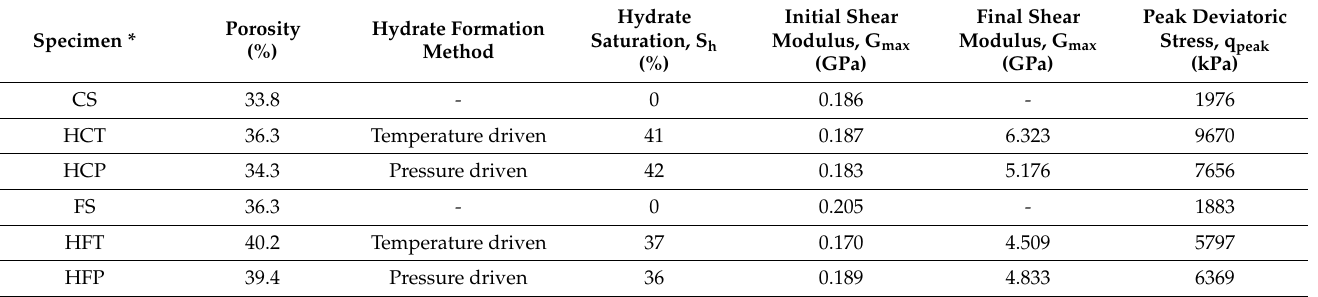
Table 2. Specimen properties, nomenclature, testing conditions, and measured parameters for specimens tested. CS and FS refer to the base sands without hydrate.